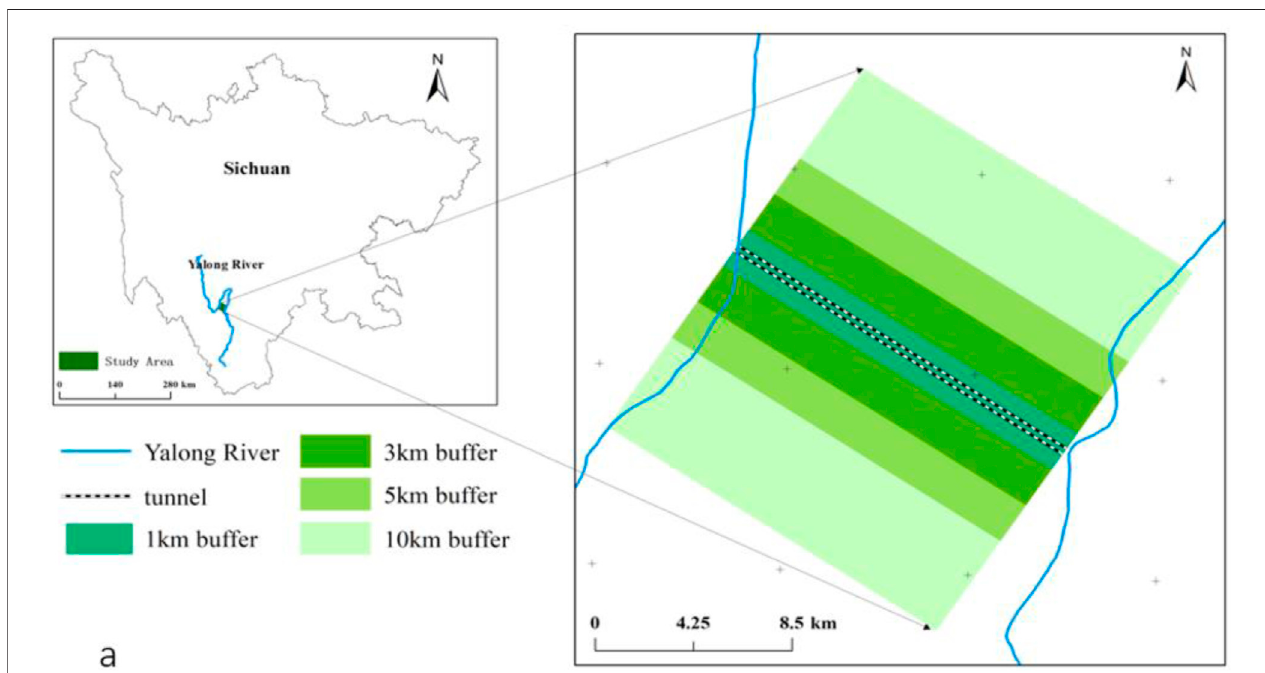
FIGURE 1 | Location of the Jinping II hydropower